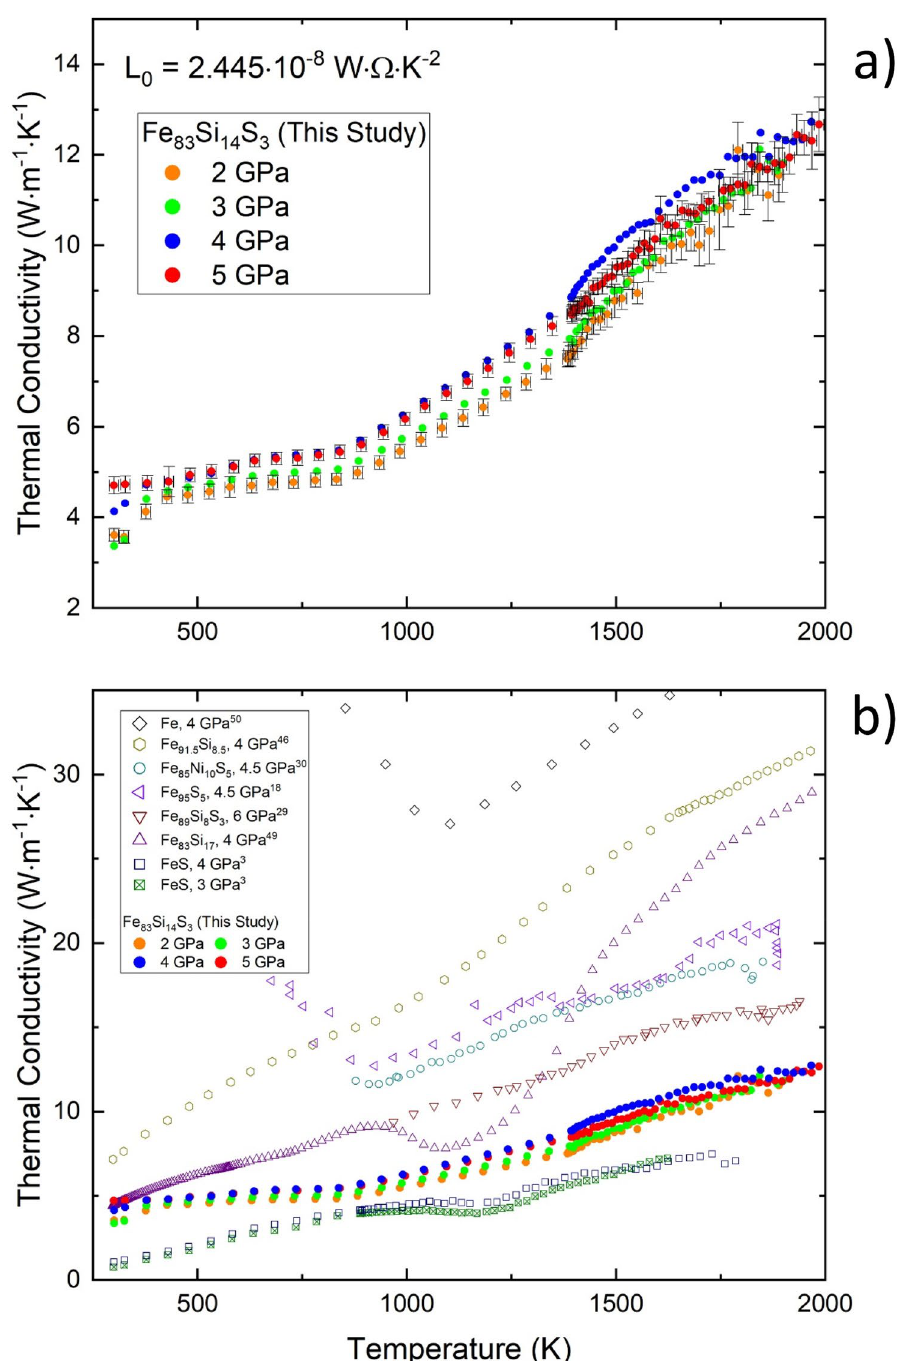
Figure 3. ( a ) Calculated electronic thermal conductivity of Fe 83 Si 14 S 3 at pressures of 2–5 GPa (± 0.2 GPa) as a function of temperature. Error bars of T and κ e are shown for all 2 and 5 GPa measurements and are representative for all measurements displayed in the figure. ( b ) Calculated electronic thermal conductivity of Fe 83 Si 14 S 3 from this study compared to several previous studies of similar or relevant compositions 3,18,29,30,46,49,50 . Low temperature values of electronic thermal conductivity of Fe (up to ~ 62 W m −1 K −1 ) are not shown for figure scaling